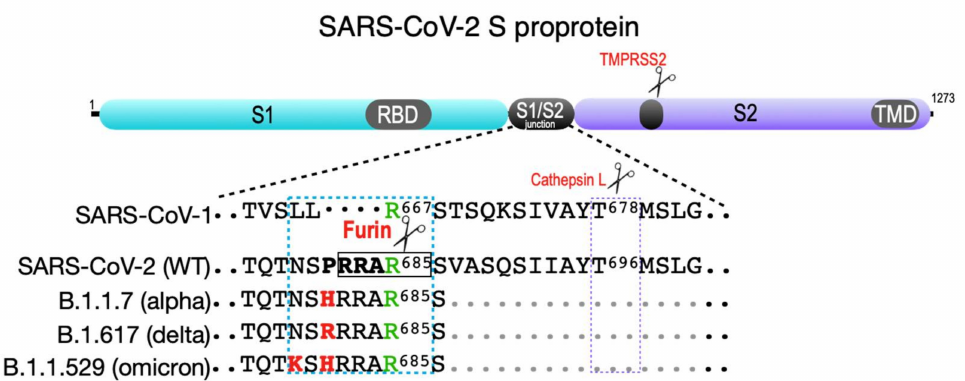
Figure 4. SARS-CoV-2 spike protein. Shown are the S1 and S2 segments in the SARS family S proprotein that flank the S1/S2 cleavage site junction as well as the ACE2 receptor-binding domain (RBD) in S1 and the transmembrane domain (TMD) in S2. The S2 (cid:48) TMPRSS2 cleavage site is common to all SARS coronaviruses (violet box). The SARS-CoV-1 S1/S2 junction is cut by cathepsin L at Thr 678 (see [74]). SARS-CoV-2 contains a four-amino-acid insertion (PRAA 684 ), which converts the trypsin- sensitive Arg 685 residue (green) to the P1 site cut by furin (RRAR 685 , boxed). The cyan box also shows the B.1.1.7 (alpha variant) furin site containing the P 681 → H change; the more transmissible B.1.617.2 (delta variant) furin site, which contains the P 681 → R change; and the recently reported B.1.1.529 (omicron variant), which contains both P 681 → H and N 679 → K